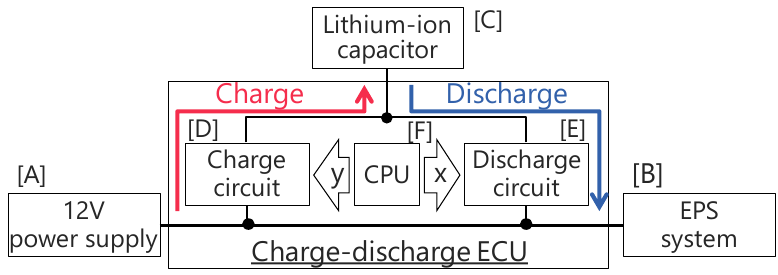
Figure 4. Charge–discharge system for EPS block diagram.